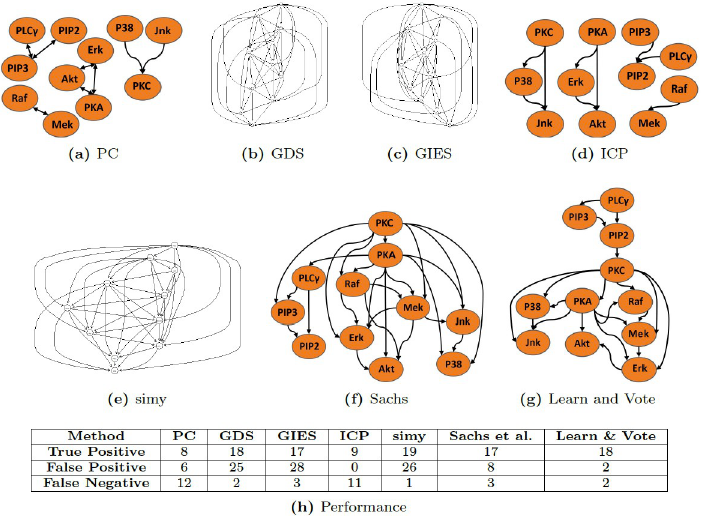
Fig 5. Consensus networks inferred from various algorithms (a-g) on the Sachs et al. cell signaling dataset. A bidirectional arrow between two nodes denotes that an interaction is predicted between the two nodes, but the direction of causality is ambiguous. In the table (h), each row corresponds to a component of the confusion matrix (true positives, false positives, and false negatives), and each column corresponds to a causal network inference